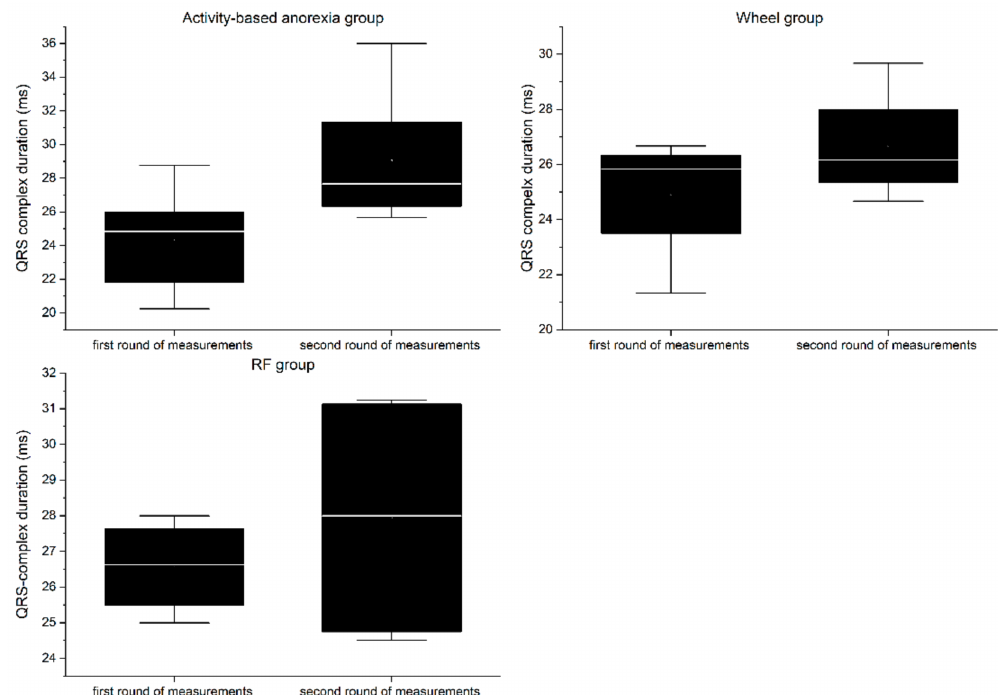
Figure 10. Boxplot of mean QRS-complex duration in the experimental groups. The first round of measurements serves as control.